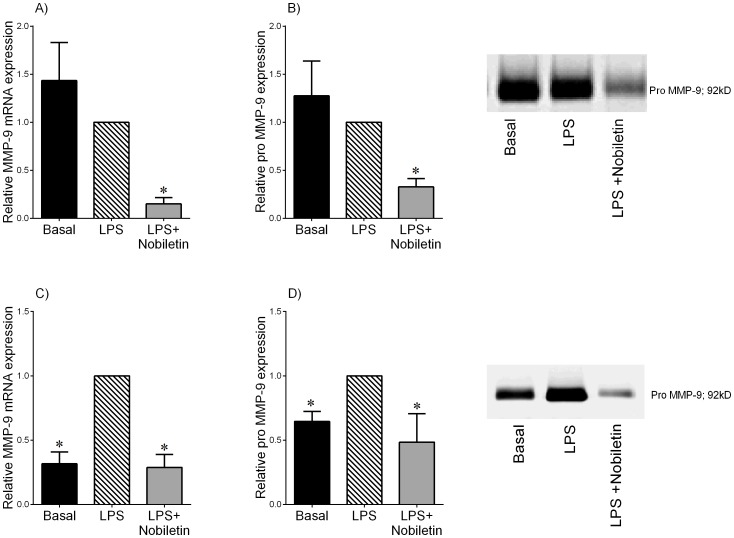
Effect of nobiletin on LPS-induced MMP-9 expression and release in term fetal membranes and myometrium.(A,B) Fetal membranes and (C,D) myometrium were incubated with or without 10 µg/mL of LPS in the absence or presence 200 µM of nobiletin for 20 h (n = 6 patients per group). (A,C) MMP-9 mRNA expression was analysed by qRT-PCR and normalised to GAPDH mRNA expression. The relative fold change was calculated relative to LPS and data presented as mean ± SEM. *P<0.05 vs. LPS (one-way ANOVA). (B,C) The incubation medium was assayed for pro MMP-9 levels by gelatin zymography. The relative fold change was calculated relative to LPS and data presented as mean ± SEM. *P<0.05 vs. LPS (one-way ANOVA). Zymography from one patient per tissue type is also shown.